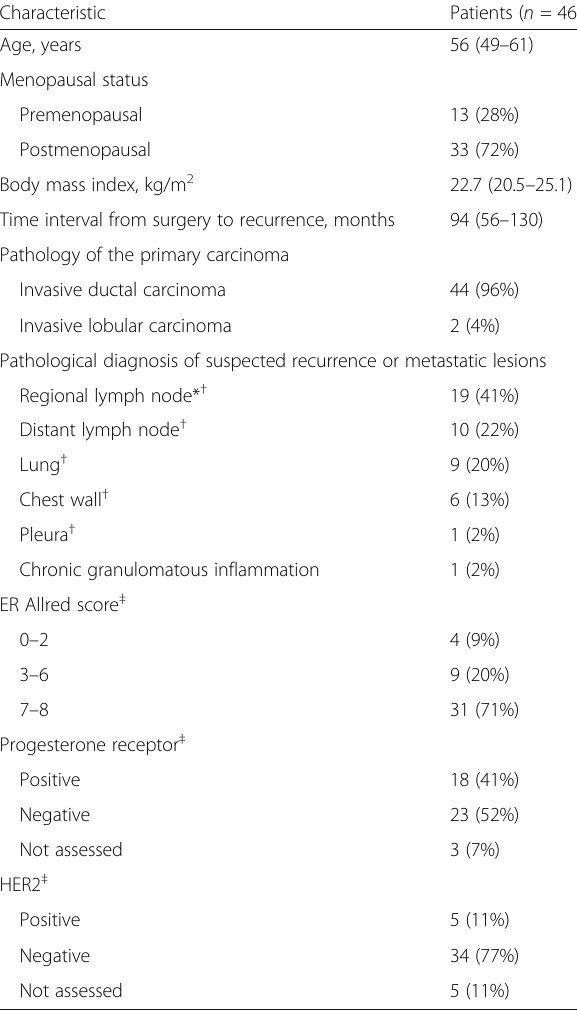
Table 1 Baseline demographic, clinical, and histological characteristics